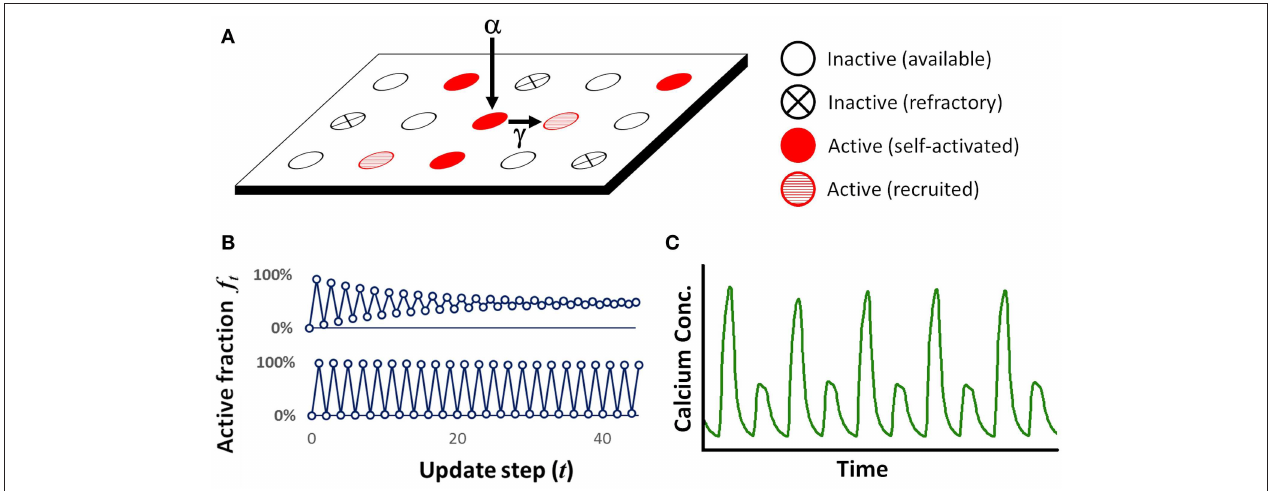
FIGURE 1 | (A) Illustration of lattice arrangement and possible states in the PCA. Available sites can self-activate with probability α , or be recruited with probability γ . (B) Example of PCA lattice simulation showing the activation fraction f t reaching either a steady state (top, for γ = 0.25) or maintaining periodicity (bottom, for γ = 0.75). In both cases α was fixed at 0.80. (C) Simplified graphical representation of a typical experimental recording of calcium concentration over time in a cardiac myocyte, under conditions that produce alternans. Each peak represents either a high or low release of calcium, and peaks are ∼ 150–300 ms apart.